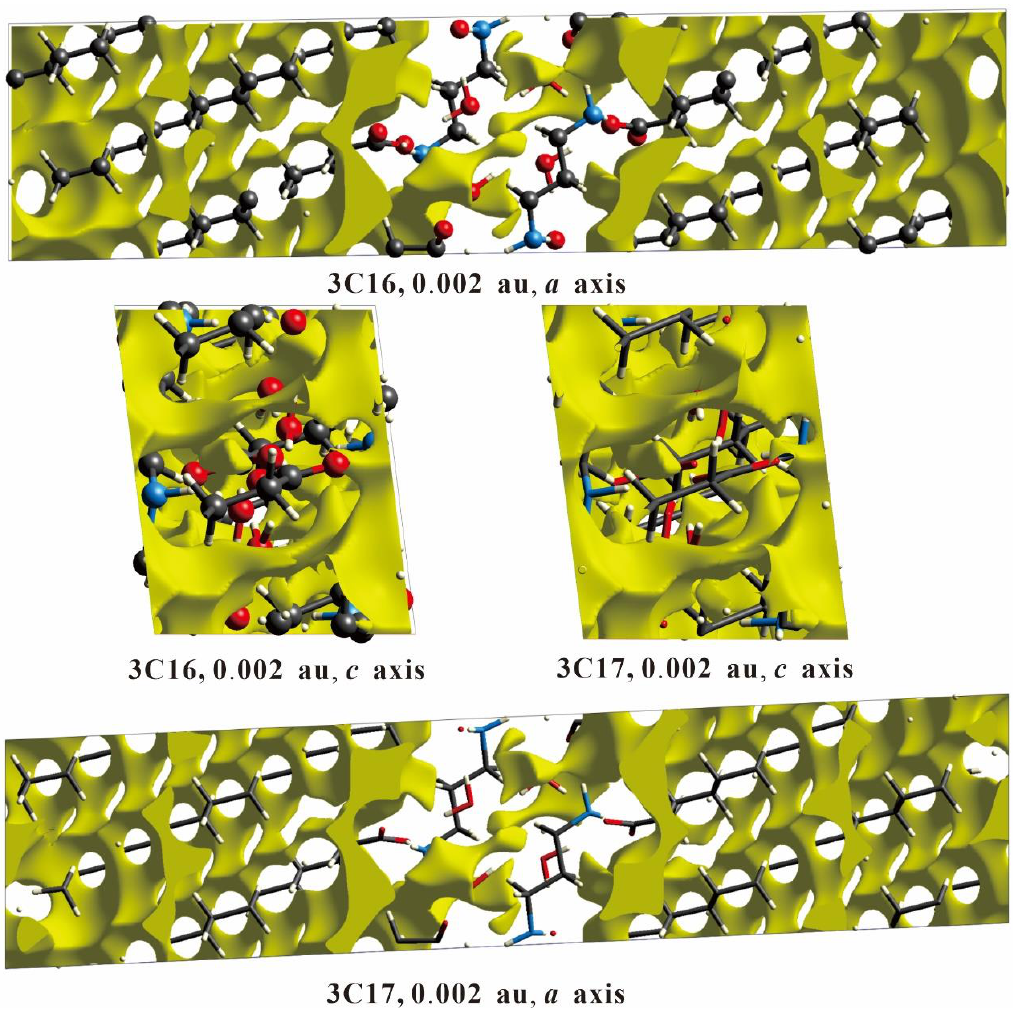
Figure 7. Void surfaces (0.002 au) for 3C16 and 3C17. The view is along the b axis and c axis in all cases, and all diagrams are on the same scale.